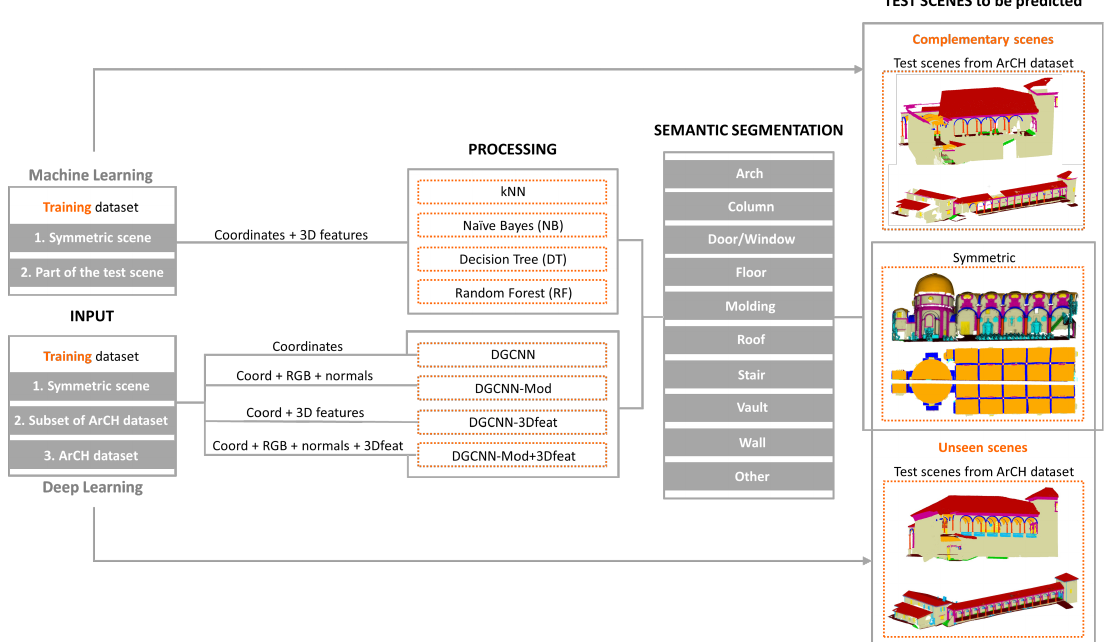
Figure 1. Workflow for the machine learning (ML) and deep learning (DL) framework